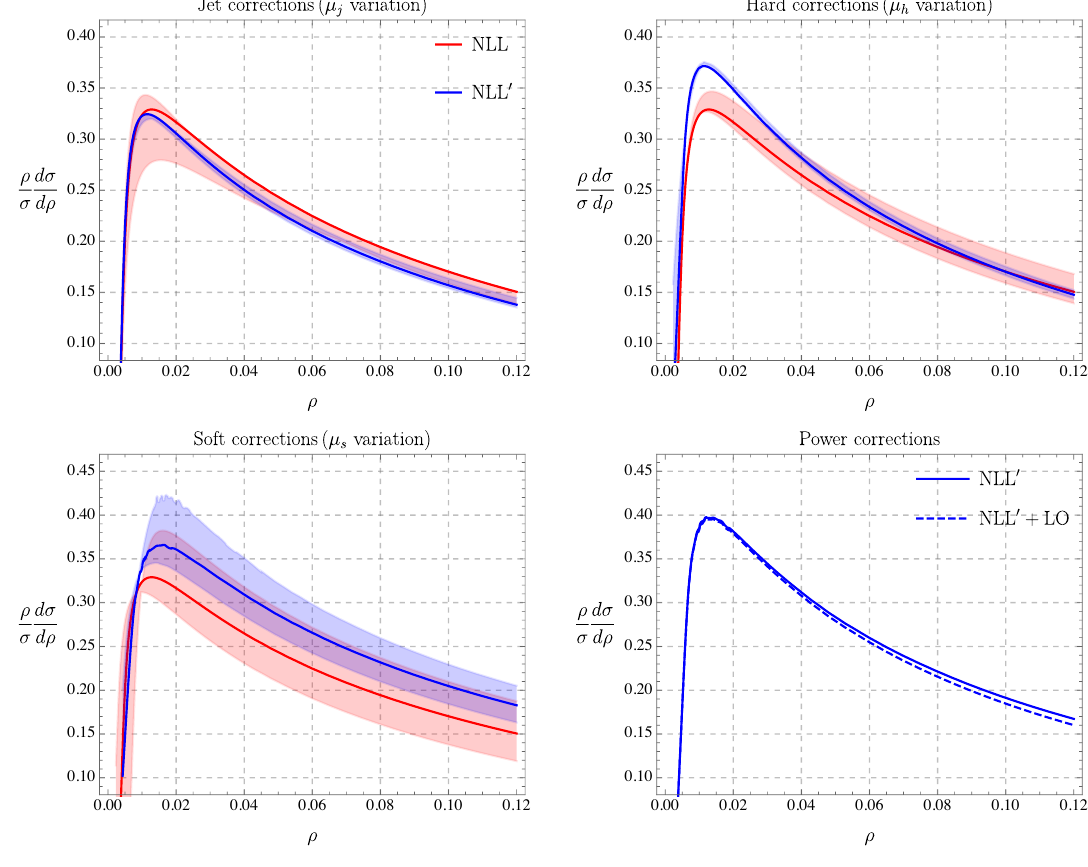
Figure 8 . NLL 0 corrections from the jet, hard and soft functions and their scale uncertainties. Each band comes from varying the scale associated with the correction by a factor of two around the default value. In the last plot we show LO power corrections from the (cid:12)xed-order